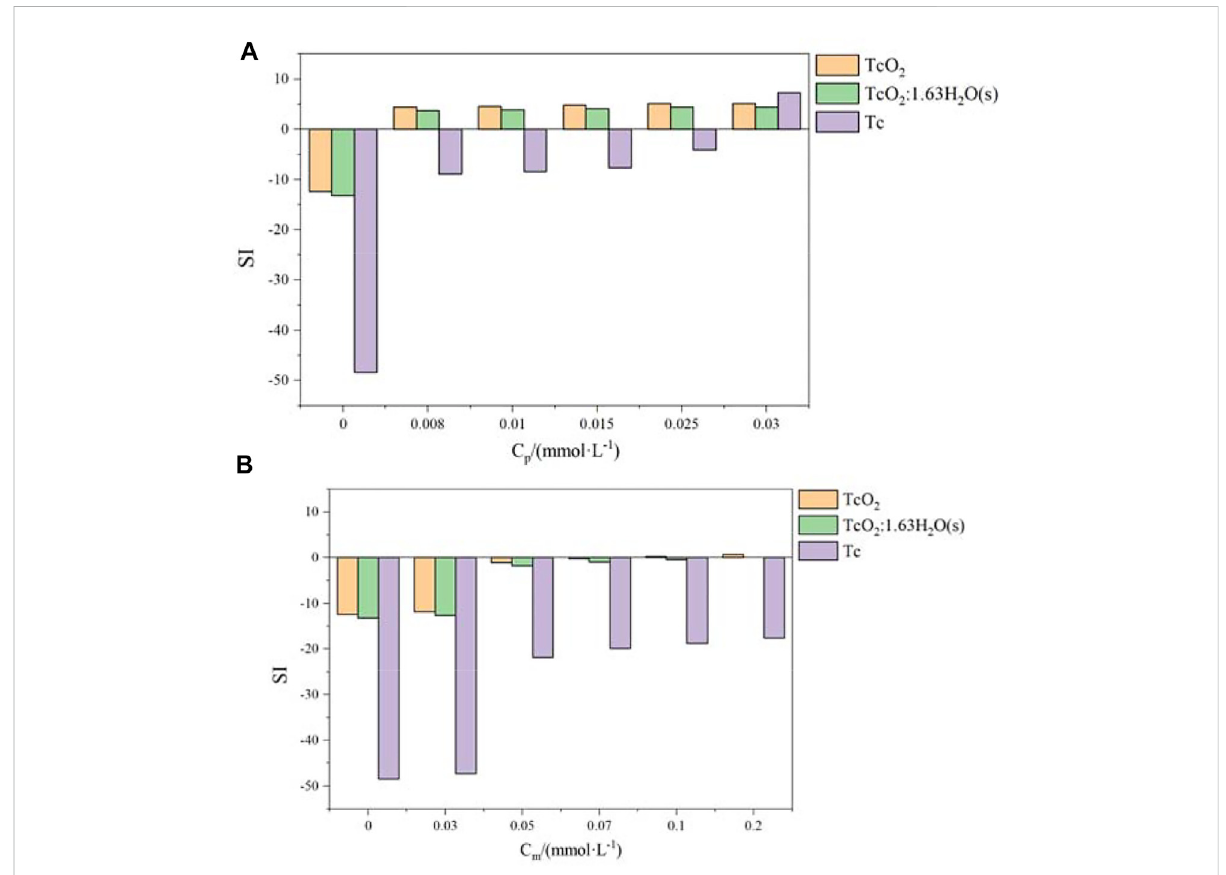
FIGURE 10 Saturation index evolution of the precipitation of TcO2(cr), Tc, and TcO2.1.63H2O(s) as a function of pyrite (A) and magnetite (B) .